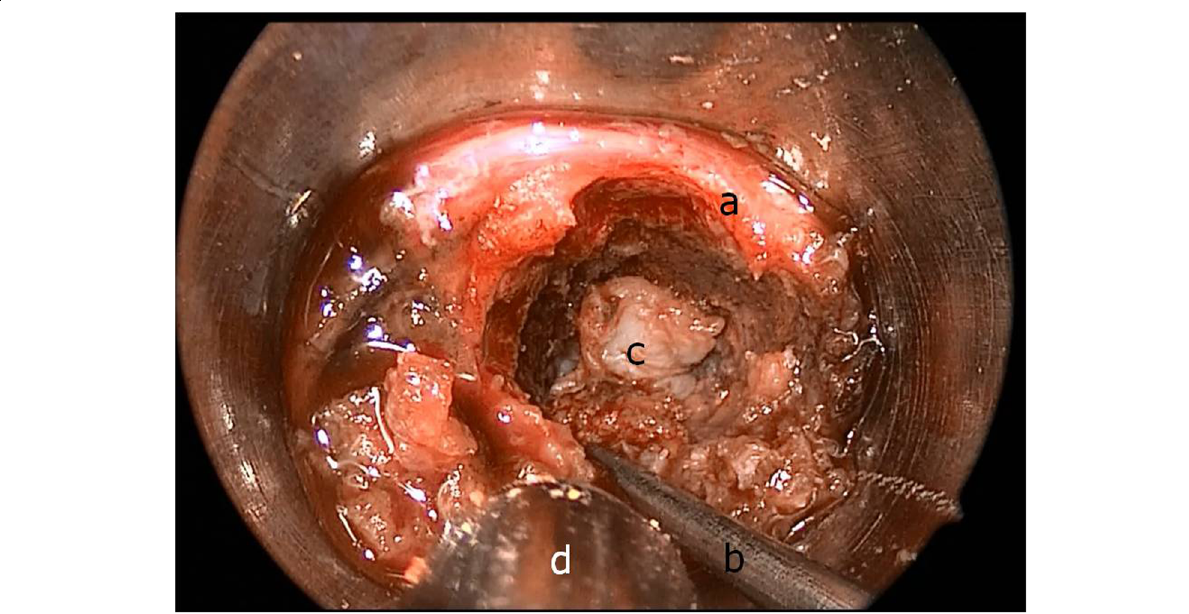
Fig. 1 Intraoperative endoscopic view during a left sided C6 – 7 fragmentectomy. a Medial bony boundary. b Microhook. c Disc fragment excision. d